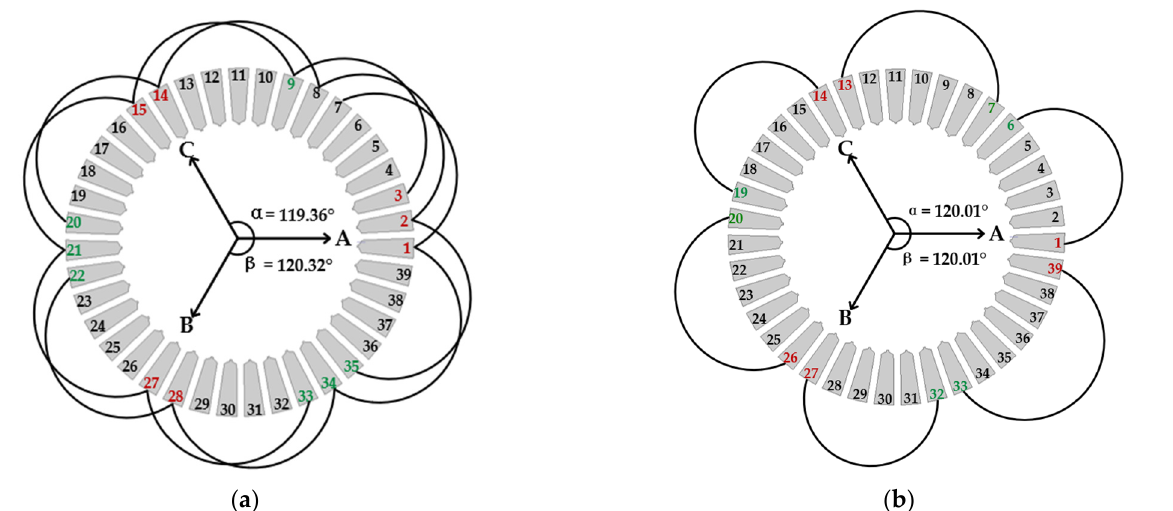
Figure 13. Phase − A coil connection and phase vector diagrams of motors: ( a ) 39 − slot and 6 − pole motor of UBW; ( b ) single − layer 39 − slot and 6 − pole motor.